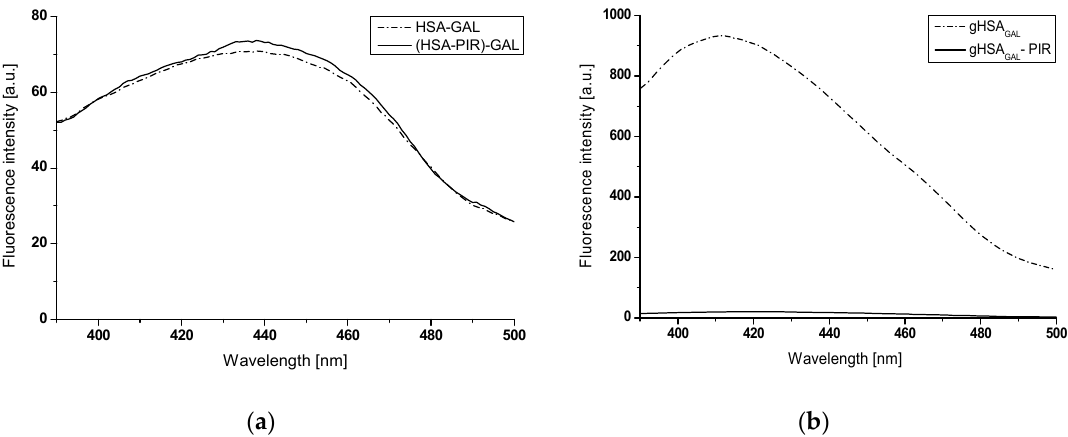
Figure 3. Advanced glycation end-products (AGEs) emission fluorescence spectra registered at λ ex = 335 nm wavelength, ( a ) in a day of solutions preparation (HSA-GLC, (HSA-PIR)-GLC, HSA-FRC, (HSA-PIR)-FRC, HSA-GAL, and (HSA-PIR)-GAL) and ( b ) after 21 days of incubation at 37 °C (gHSA GLC , gHSA GLC -PIR, gHSA FRC , gHSA FRC -PIR, gHSA GAL , and gHSA GAL -PIR), [HSA] 2 × 10 − 6 mol ∙ L − 1 , [PIR] 5.3 × 10 − 6 mol ∙ L − 1 , and [GLC, FRC, GAL] 0.05 mol ∙ L − 1 .